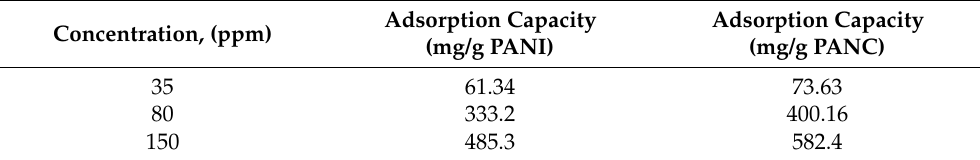
Figure 6. Schematic diagram of polyaniline-ammonia interaction. Table 2. Adsorption capacity of NH 3 over PANI and PANC at different inlet gas concentrations.